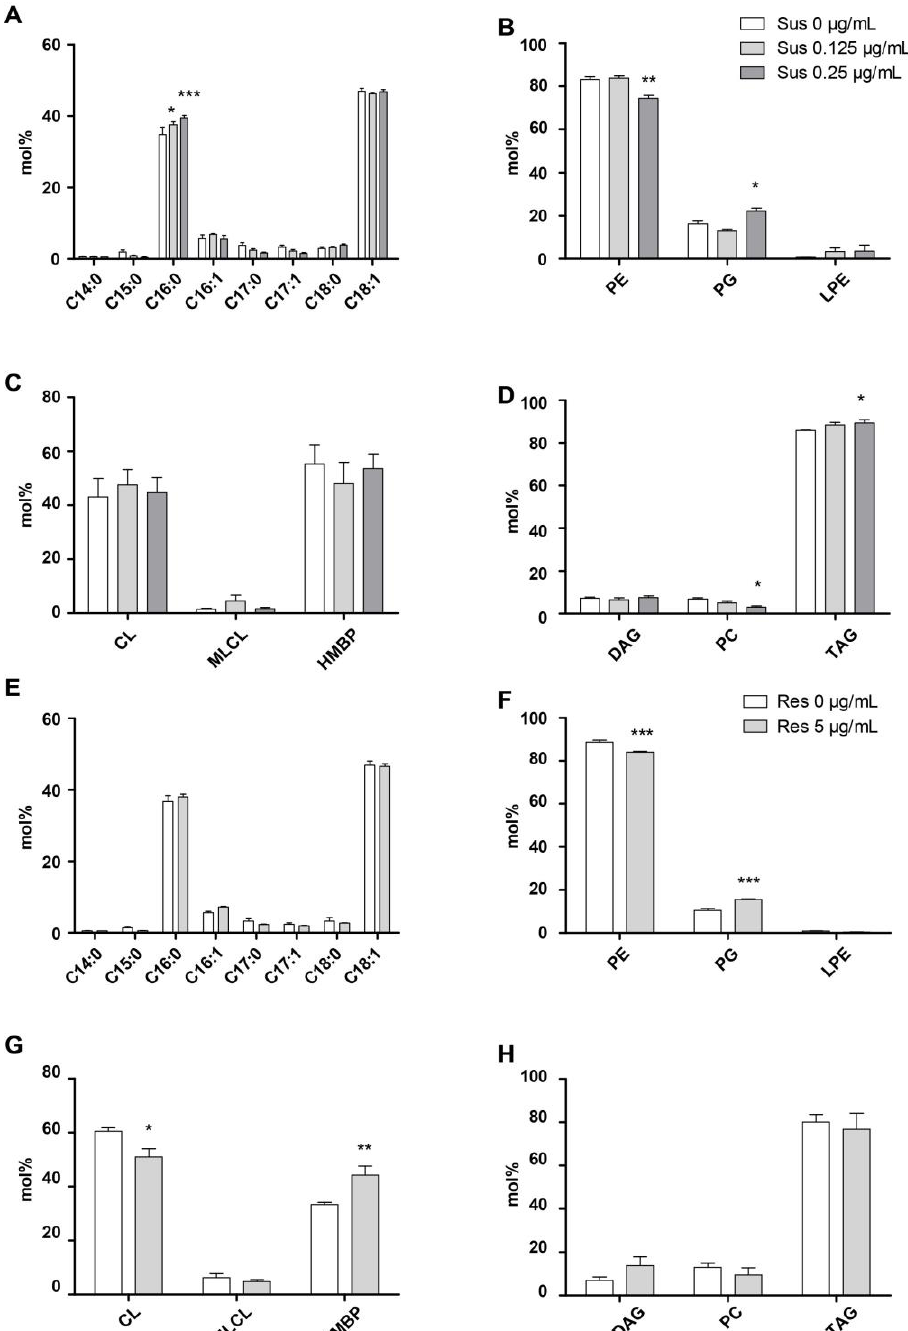
Figure 2. A. baumannii 721164 lipid content differs when incubated with colistin. ( A ) Fatty acid methyl ester analysis of A. baumannii 721164 by GC-FID cultivated without or with colistin at 0.125 µg/mL or 0.25 µg/mL. ( B – D ) mol % of different lipid species analyzed by LC-MS. ( E ) Fatty acid methyl ester analysis of A. baumannii 721164 resistant to colistin by GC-FID cultivated without or with colistin at 5 µg/mL. ( F – H ) mol % of different lipid species analyzed by LC-MS. The results correspond to n = 3 biologically independent samples. Statistical significances were determined by a two-tailed student’s t test ***, p ≤ 0.001; **, p ≤ 0.005; *, p ≤